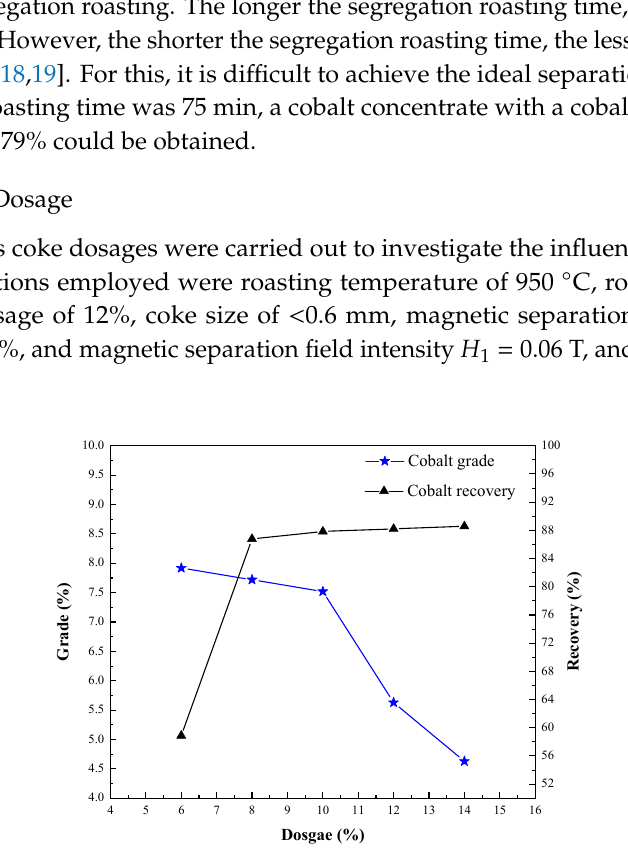
Figure 10. Effect of coke dosage on cobalt extraction. Figure 10. E ff ect of coke dosage on cobalt